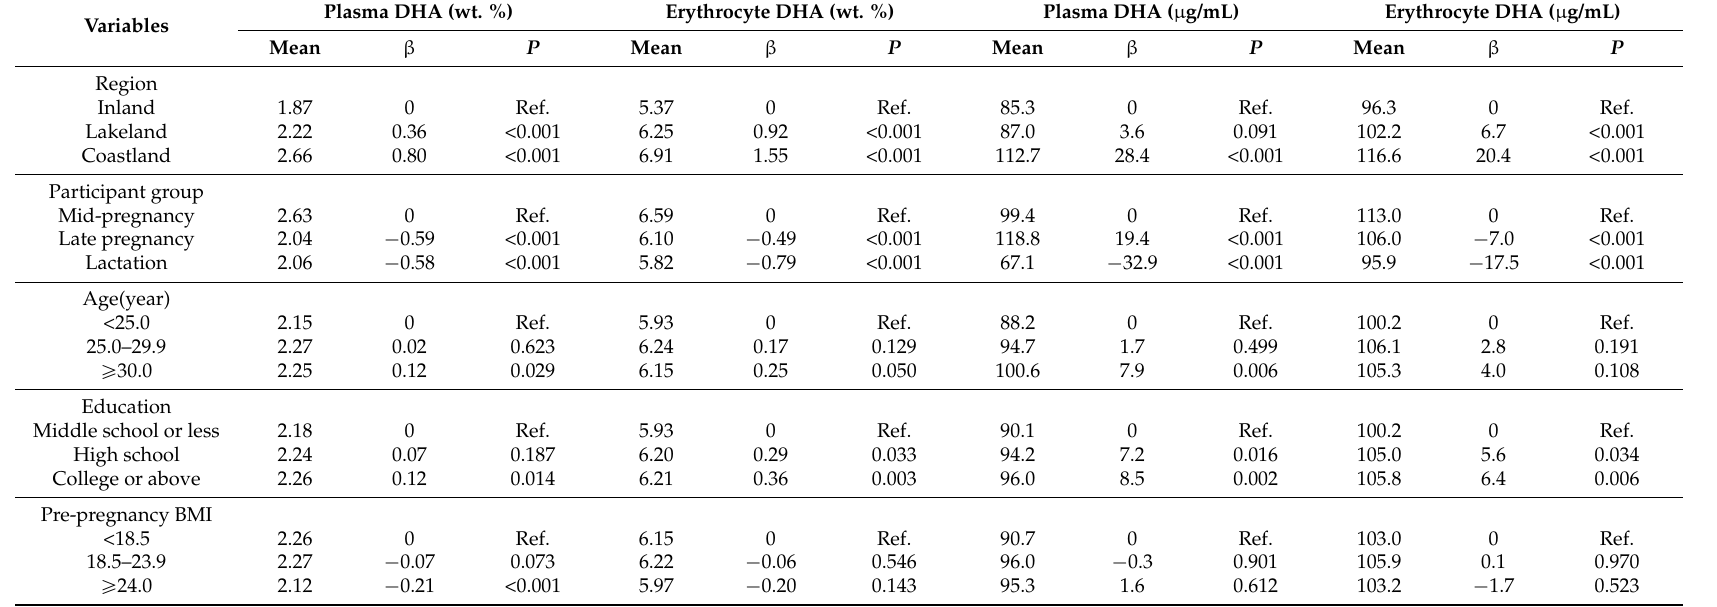
Table 3. Multiple linear regression of DHA concentrations on region, participant group and selected maternal